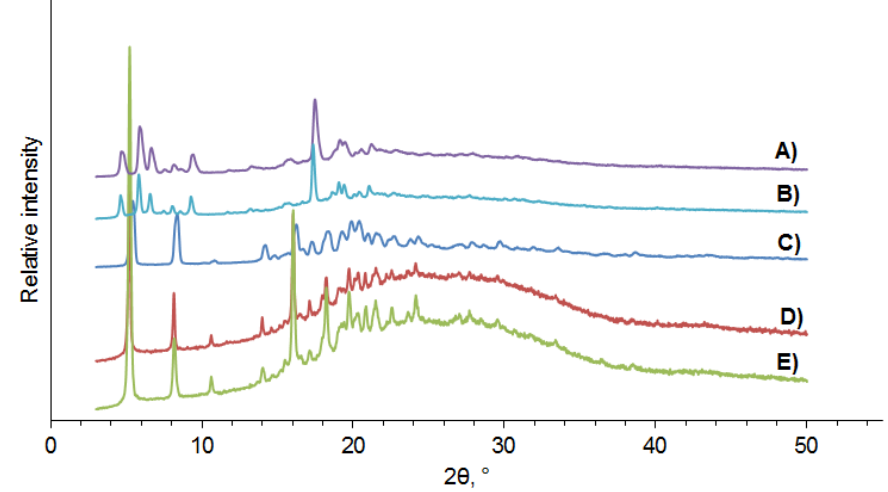
Figure 5. PXRD data for the ( A ) initial form of 4 , ( B ) thiacalix[4]arene 4 melted at 60 °C, ( C ) initial form of 5 , ( D ) thiacalix[4]arene 5 after melting and cooling, ( E ) thiacalix[4]arene 5 reheated to 80 °C.